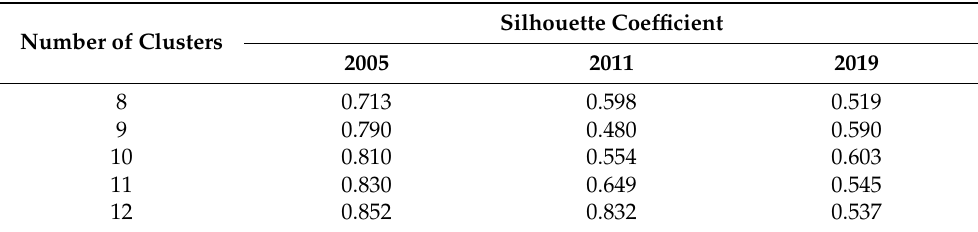
Table 4. Silhouette coefficients for the 2005, 2011, and 2019 classifications and the selected number of clusters.